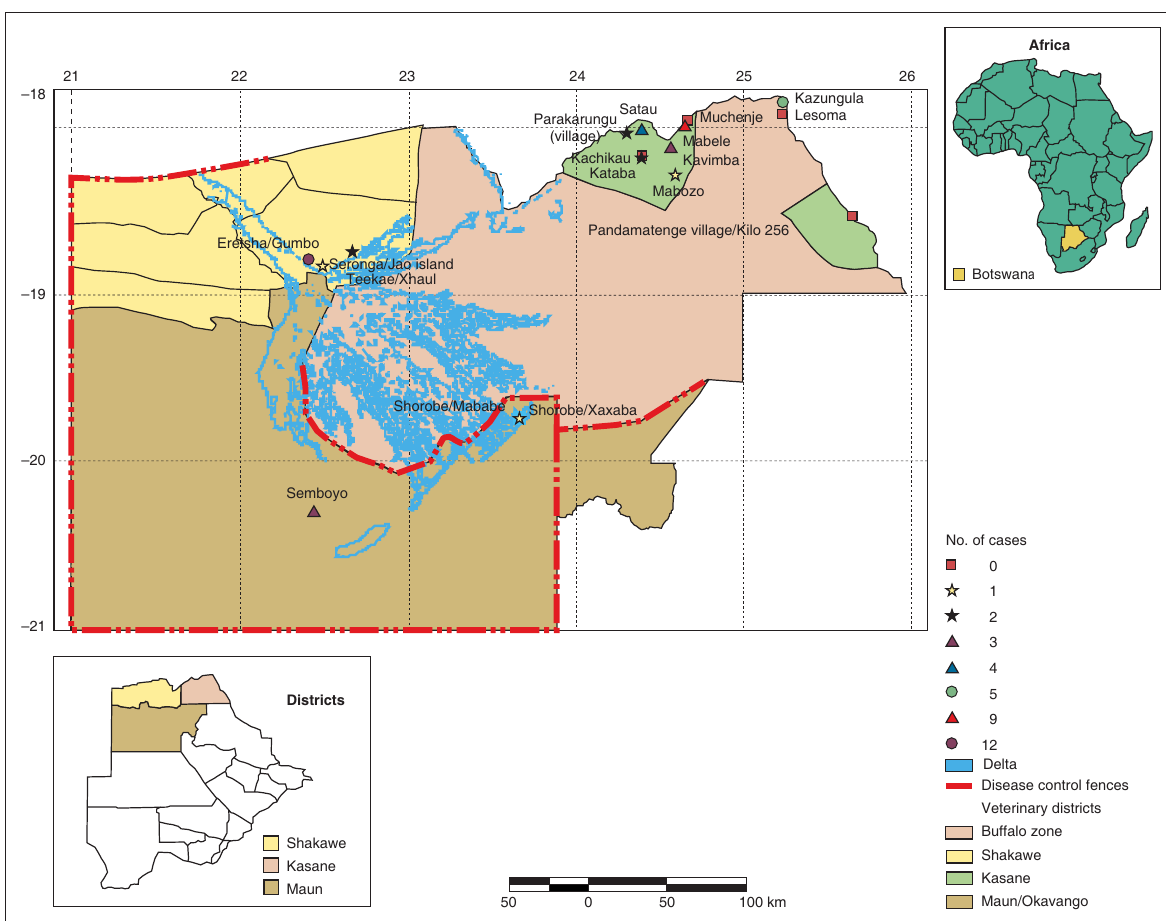
FIG. 1 Map of northwestern Botswana illustrating the geographical distribution of seropositive goats TABLE 1 Prevalence of FMD antibodies in indigenous goats in northwestern Botswana